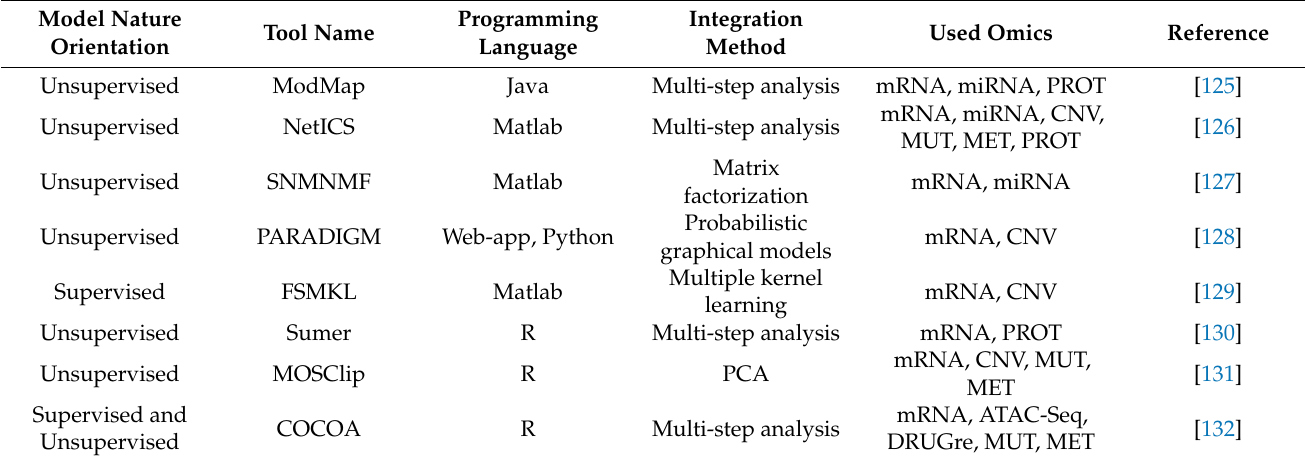
Table 4. Summary of computational tools for pathway analysis in the field of multi-omics data integration. Model Nature